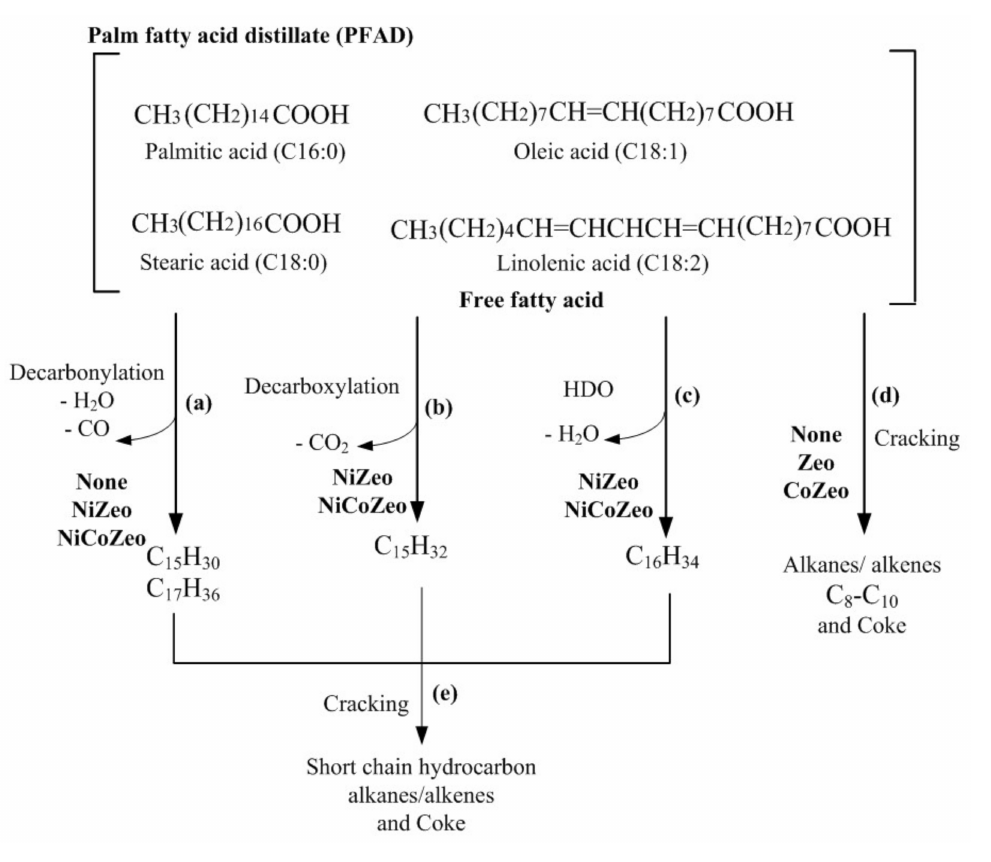
Figure 10. Deoxygenation reaction pathways of